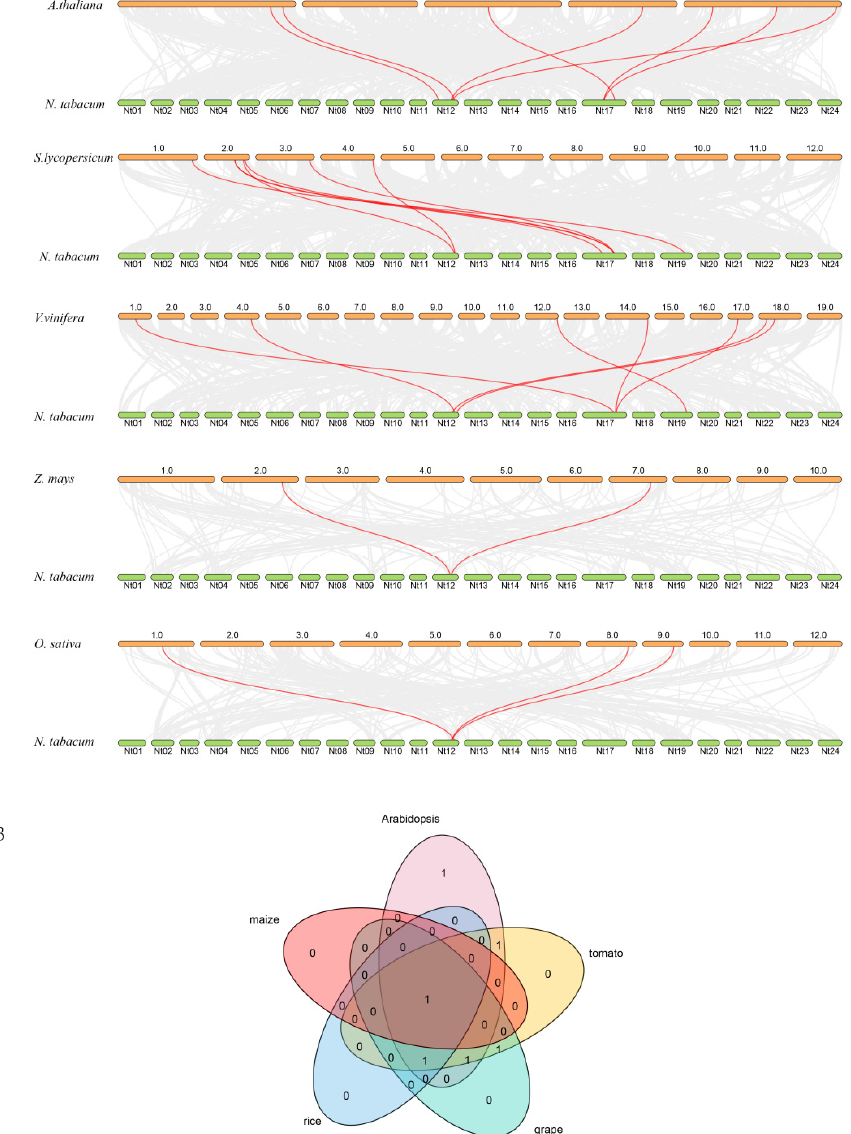
Figure 2. Syntenic analysis of ZF-HD genes between tobacco and five other representative species. ( A ) The gray line in the background represents the colinear blocks between tobacco and five other representative species, while the red line represents the syntenic ZF-HD gene pairs. ( B ) The numbers of ZF-HD genes that formed syntenic pairs between ZF-HD and the other four selected species, which was visualized by the Venn diagram.